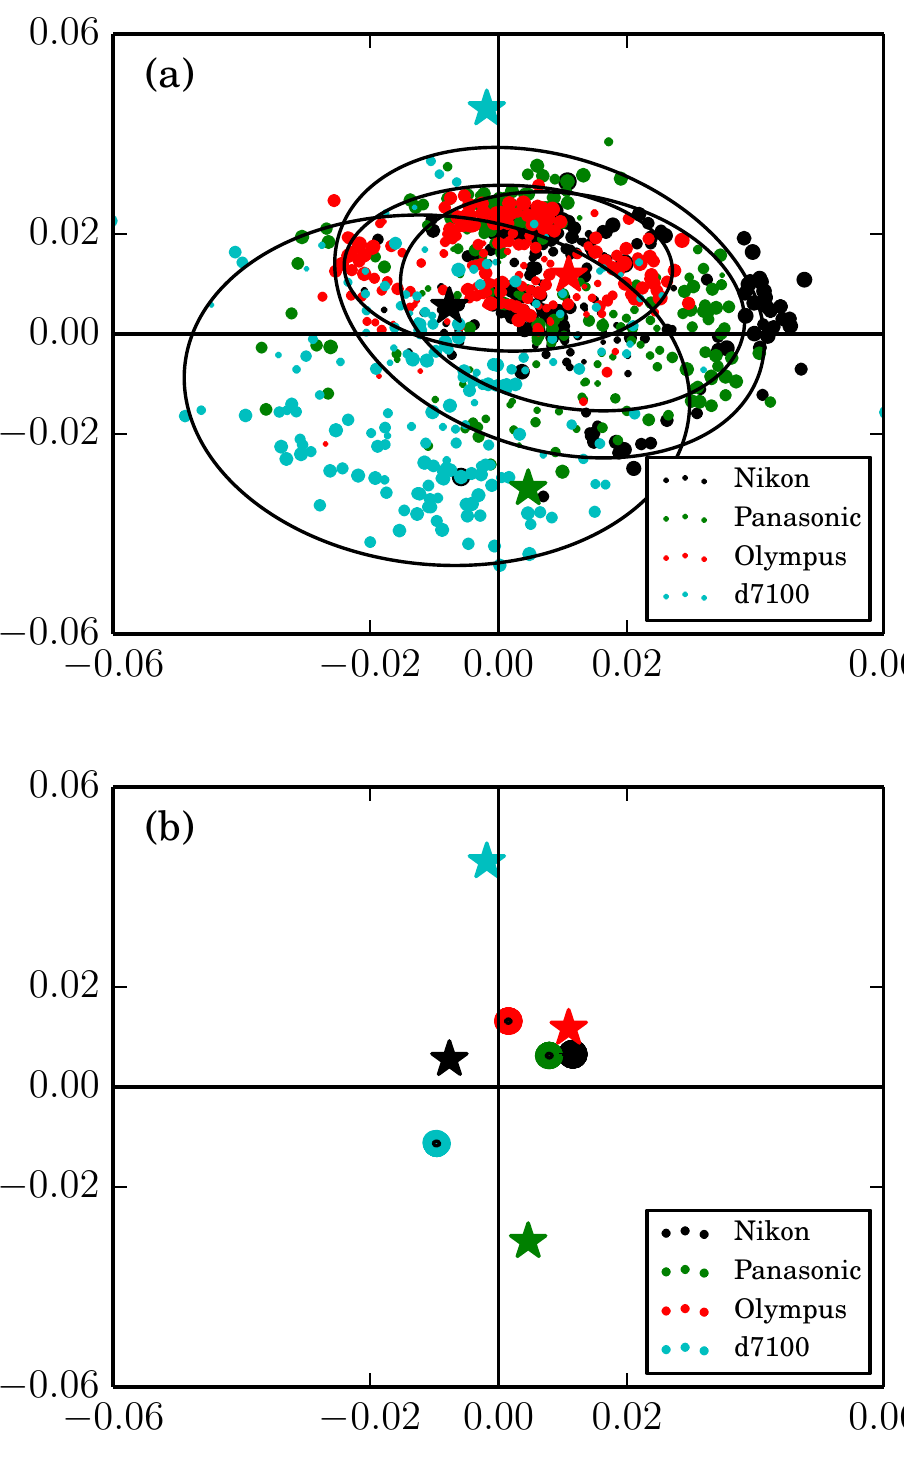
Figure 6. ( a ) Center of distortion results from EPOS are shown as dots, while reference results are marked as stars. Ellipses describe sample variances; ( b ) The same data displayed through weighted sample averages with reference results. See the text for